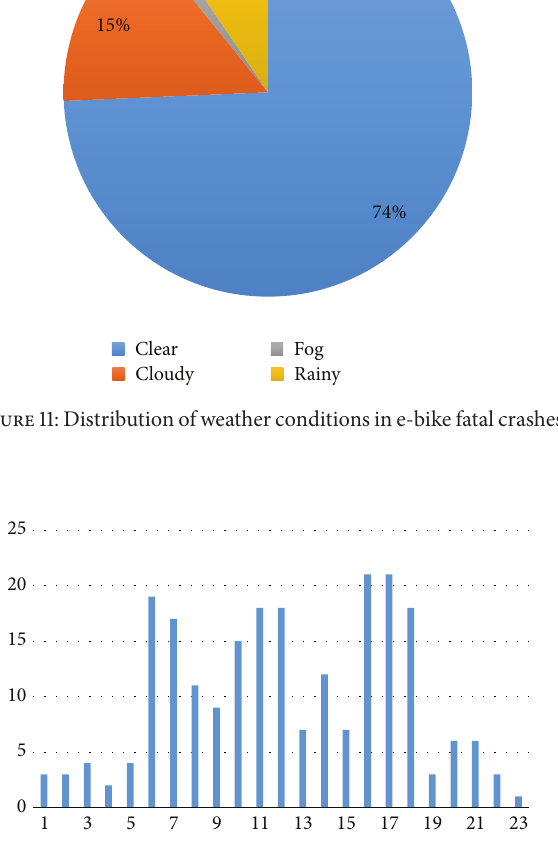
Figure 12: Temporal distribution of e-bike fatal crashes.